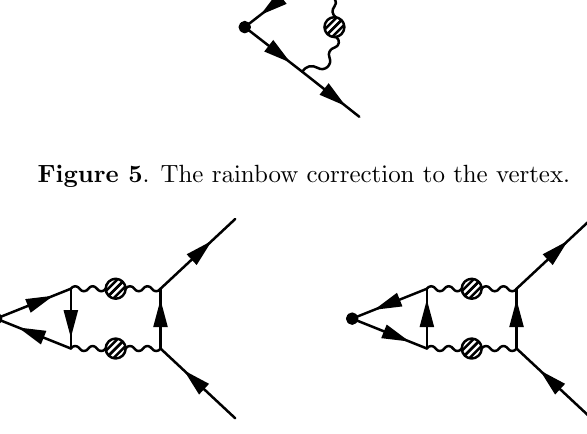
Figure 6 . Additional contributions to the two-point